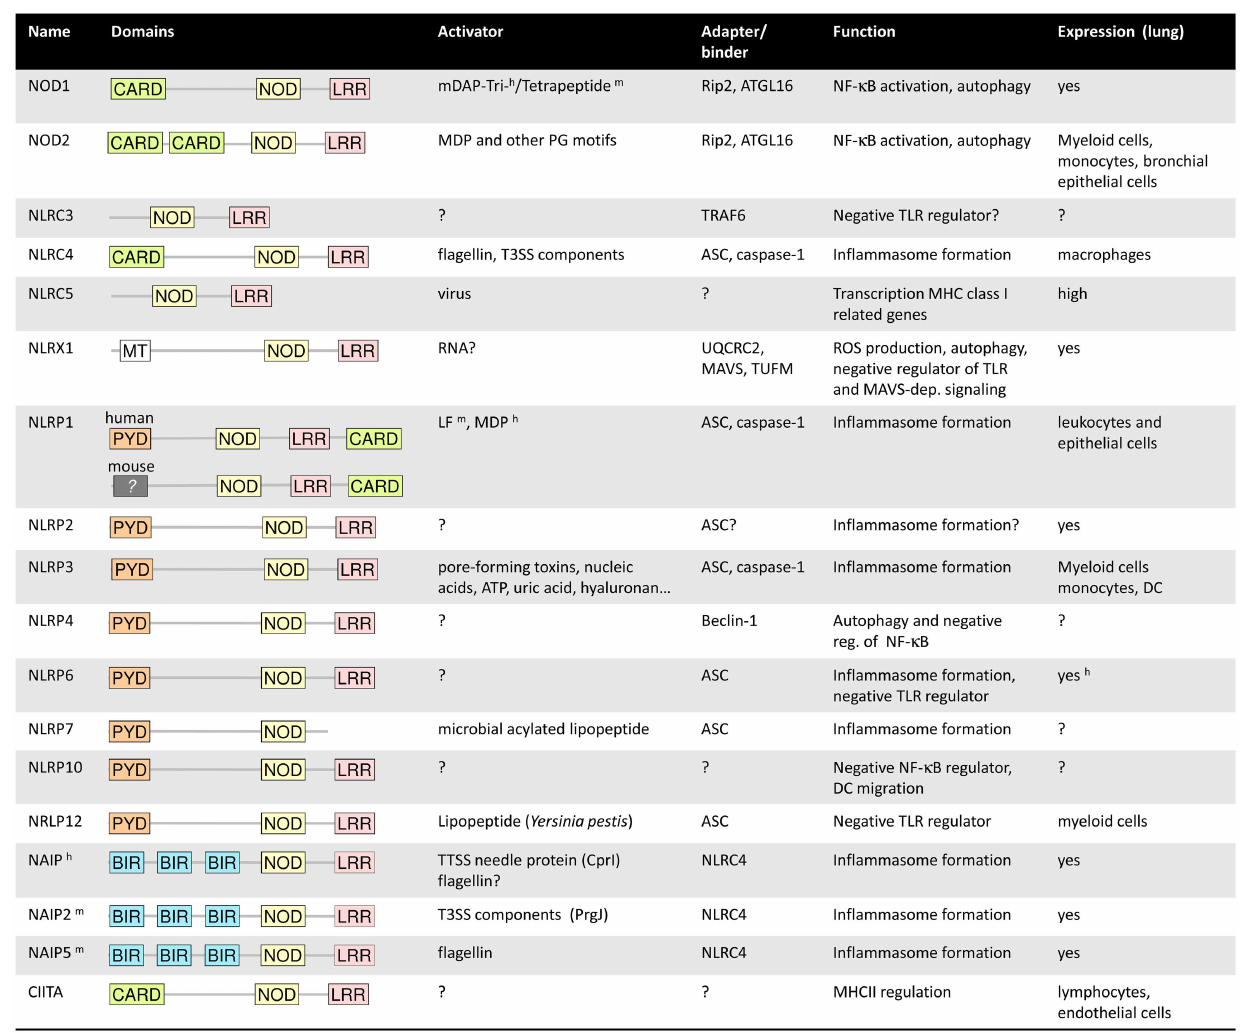
FIGURE 1 | Summary of the main characteristics of the NLRs . h and m symbolized a characteristic specific to human or mouse. For more details, refer to the main